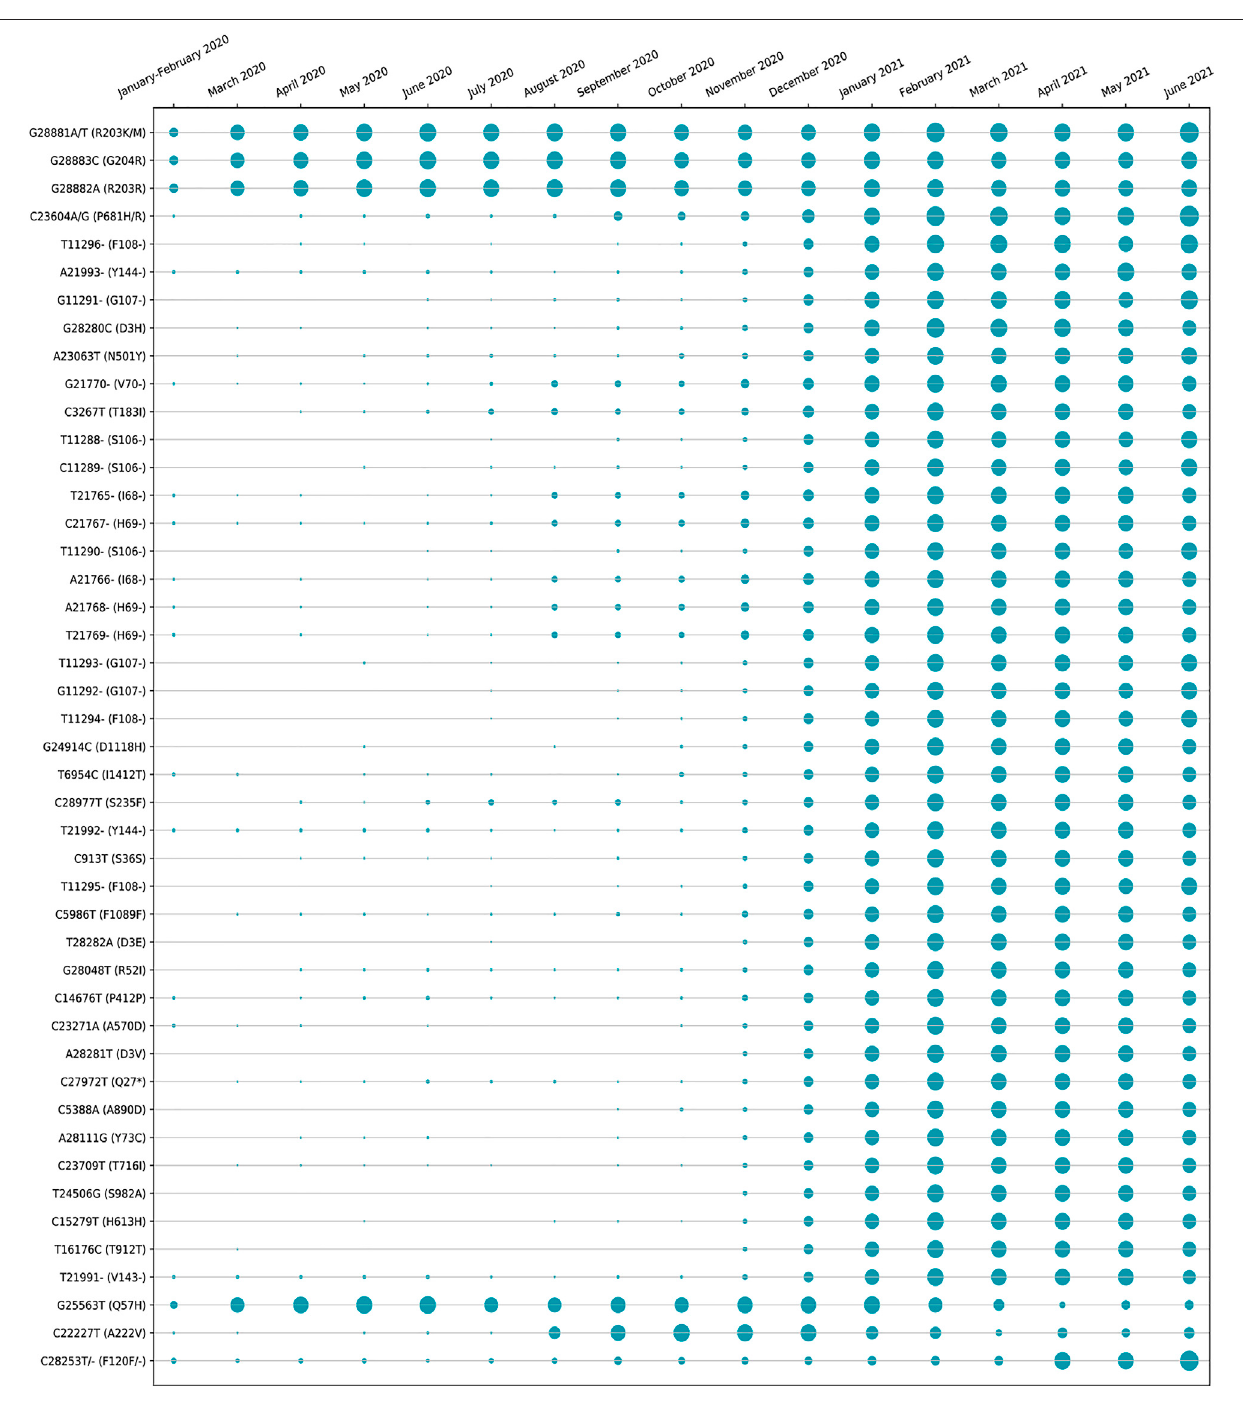
Frontiers in Genetics |